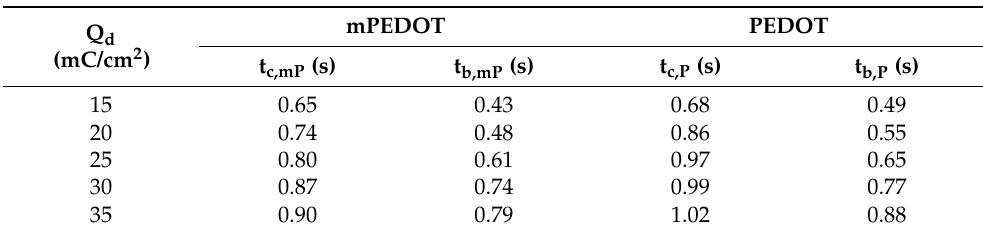
Figure 5. Transmittance responses (at 630 nm) of the mP25 and the P25 thin films during successive potential switches between their colored state ( − 1.1 V vs. Ag/Ag + ) and bleached state (0.3 V vs. Ag/Ag + ). The electrolyte was a PC solution containing 0.1 M LiClO 4 and 1.0 mM HClO 4 . Table 4. Coloring and bleaching response times of the mPEDOT and PEDOT thin films electrode- posited with different Q d